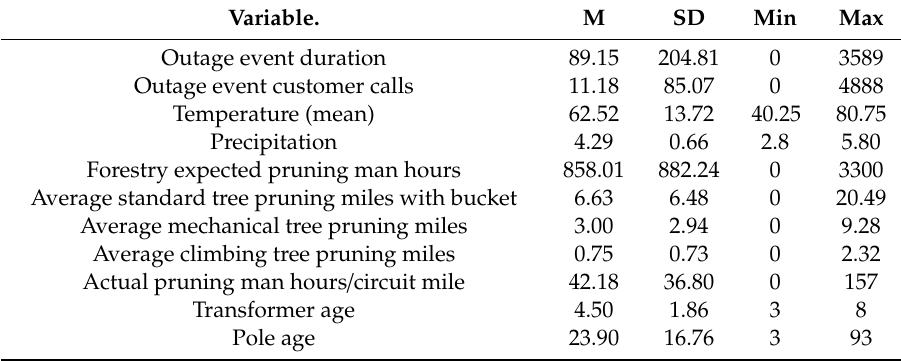
Table 3. Descriptive statistics of study